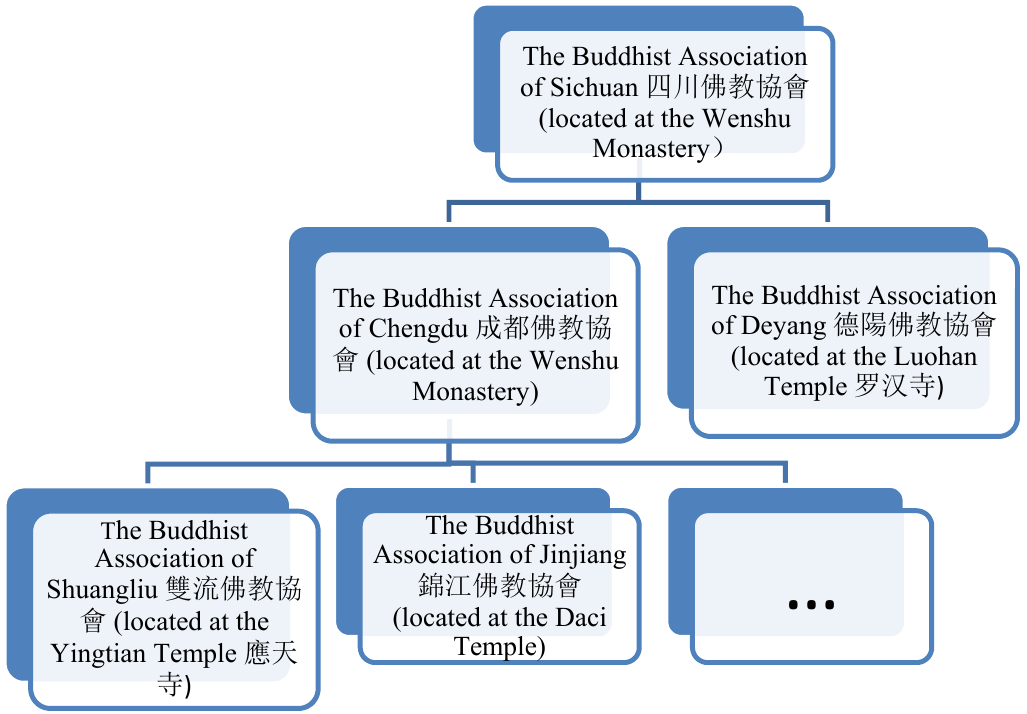
Figure 2. The structure of the Buddhist associations in Sichuan after 1987 (Wenshu Monastery 2009, p. 37).